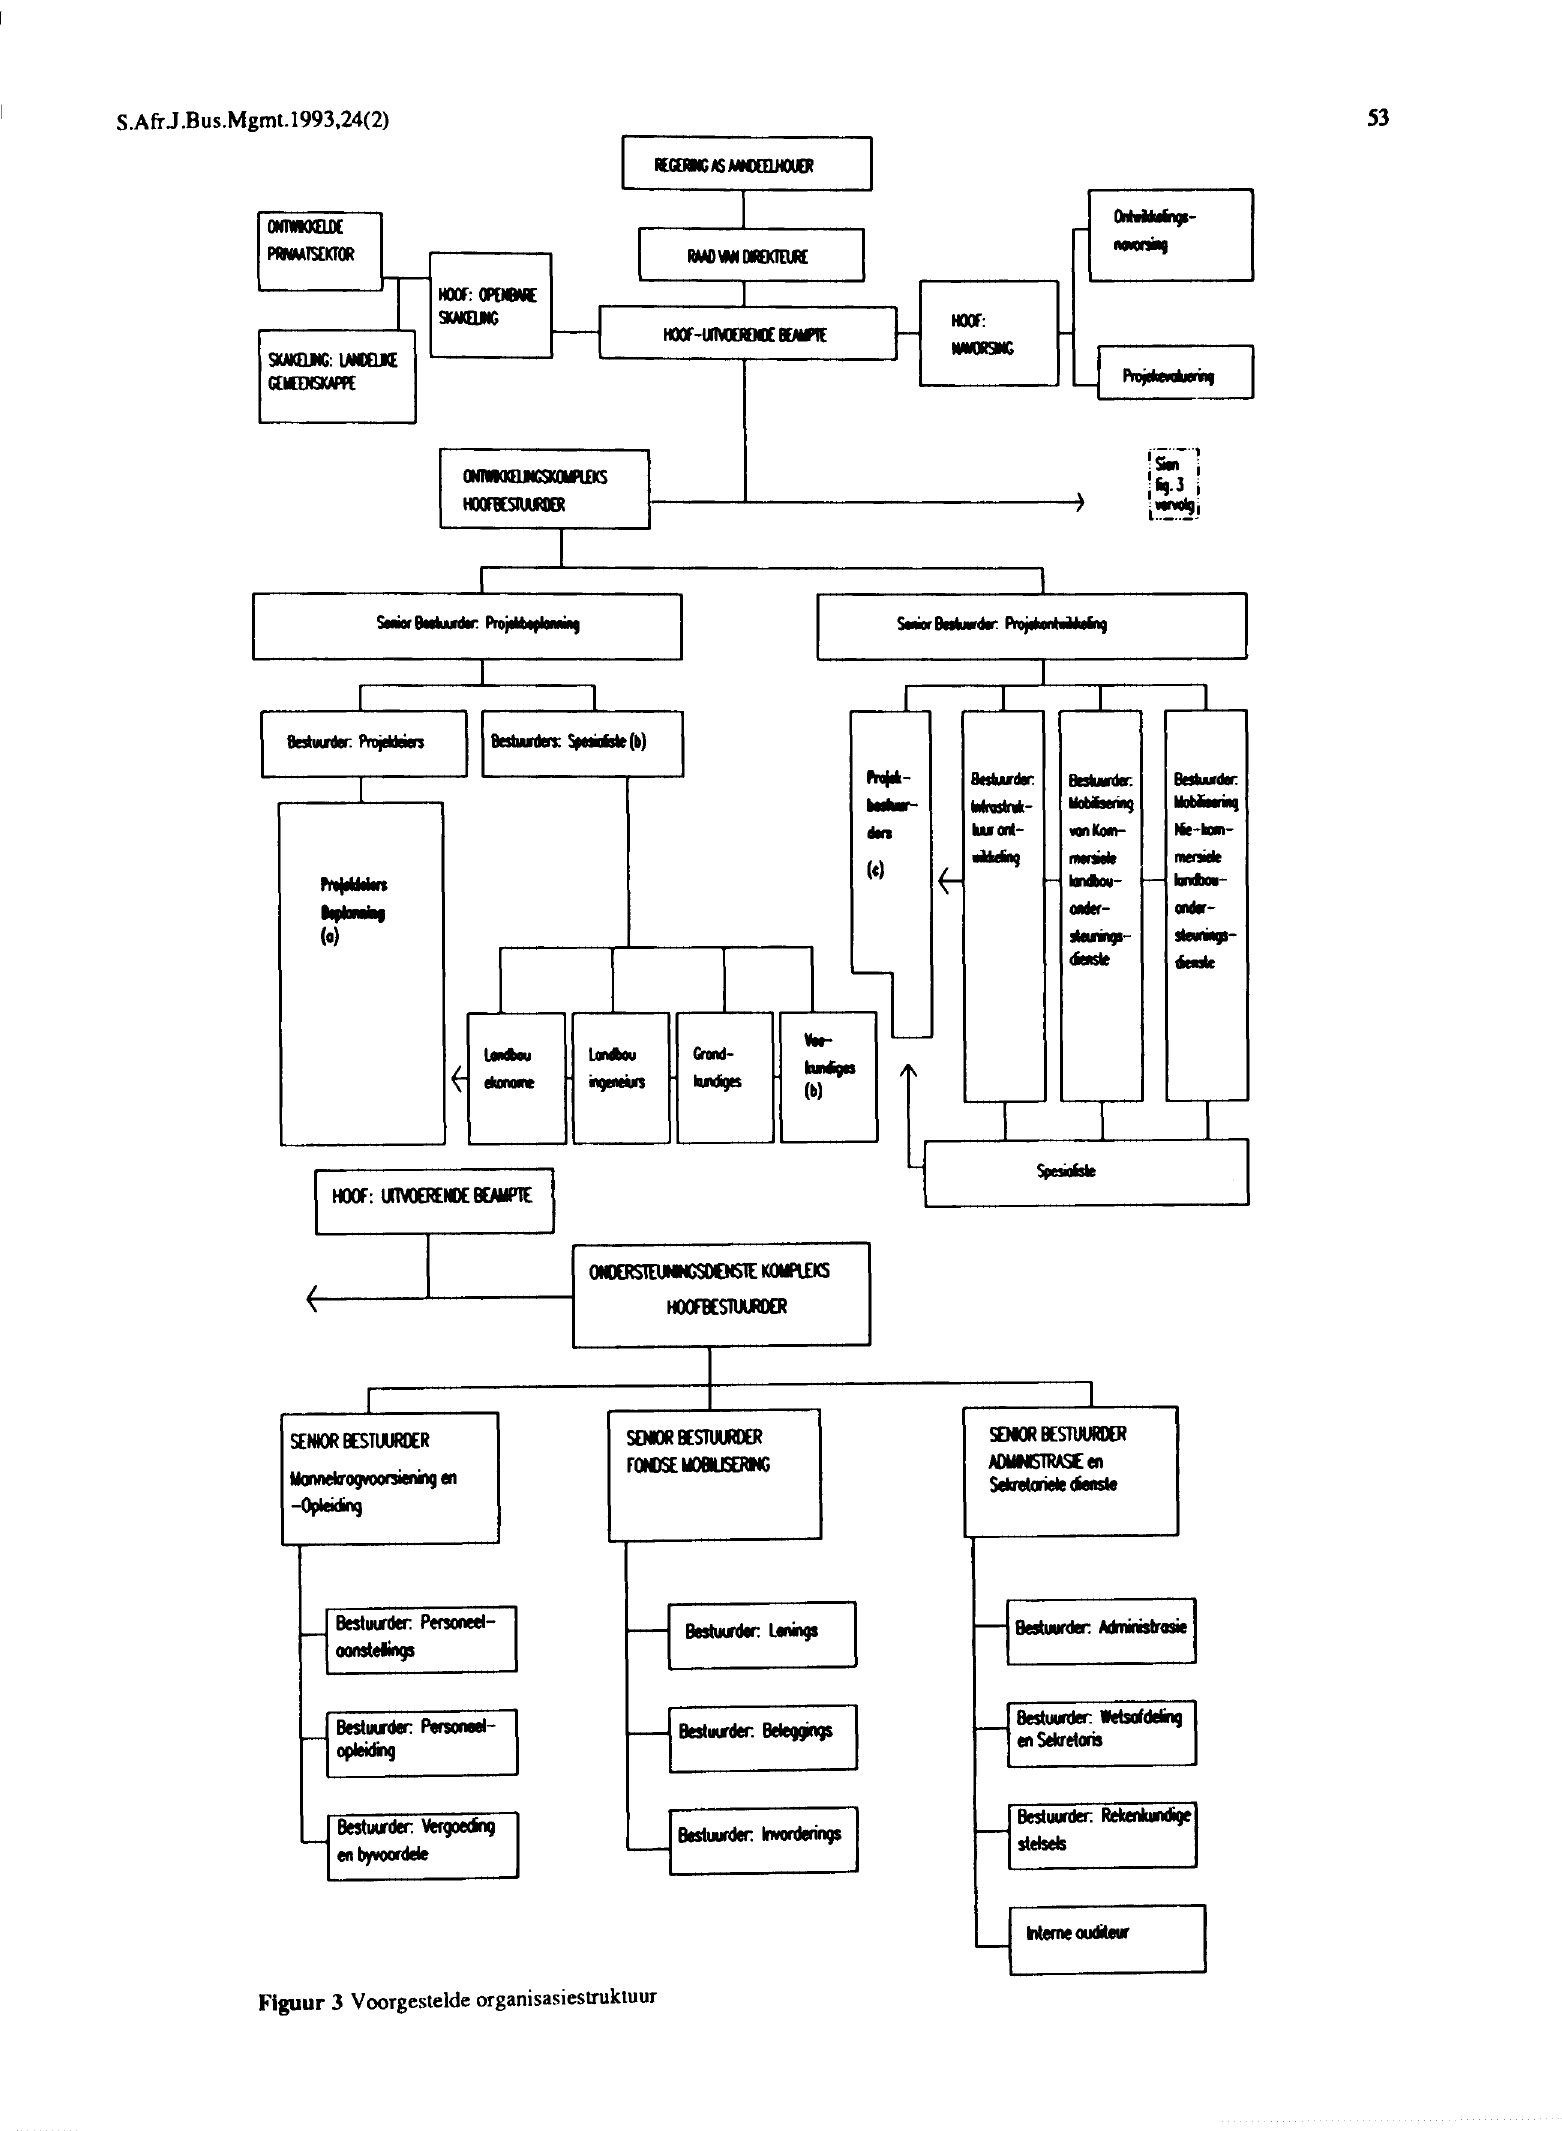
Figuur 3 Voorgestelde